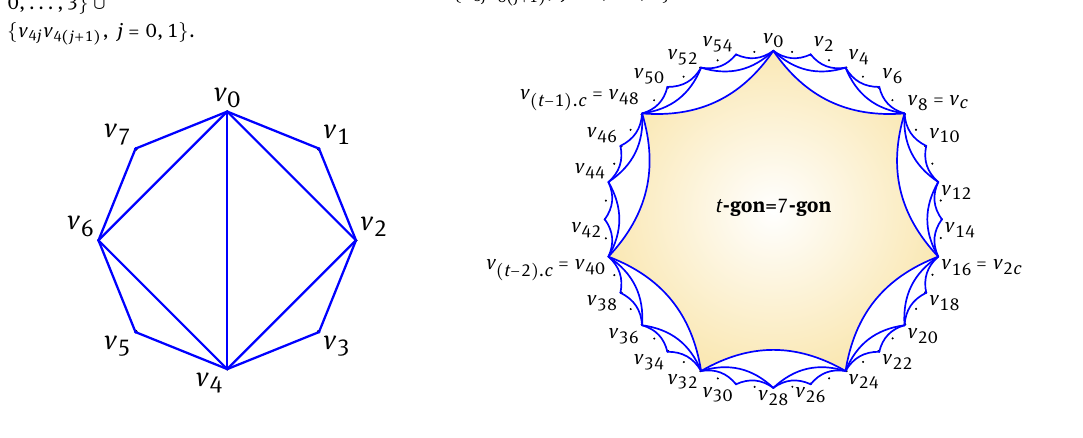
Fig. 3. n = 56 = 7.2 3 , t = 7 , r = r ′ = 3 , T 56 = { v j v ( j + 1 ) , j = 0, . . . ,55 }∪{ v 2 j v 2 ( j + 1 ) , j = 0, . . . ,27 }∪{ v 4 j v 4 ( j + 1 ) , j = 0, . . . ,13 }∪ { v